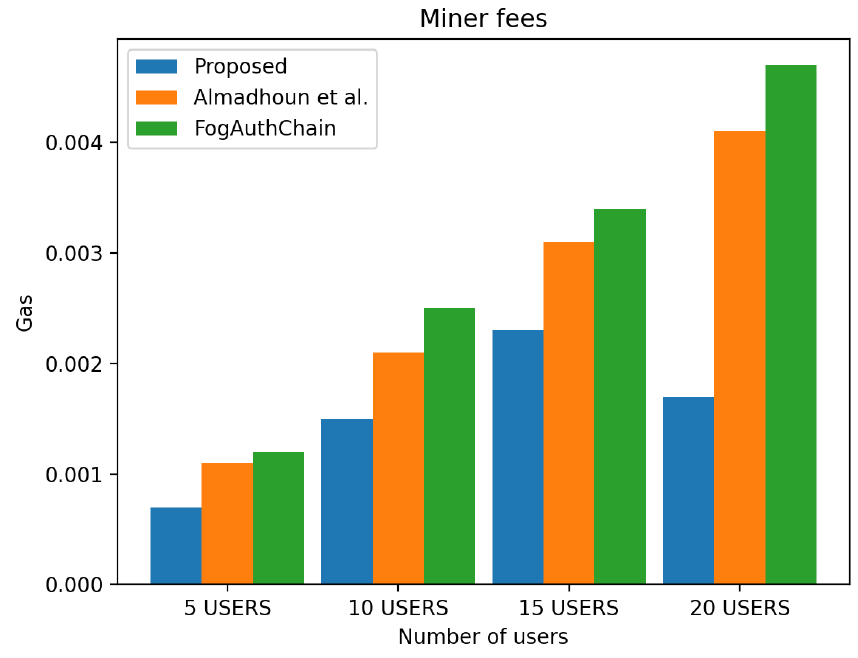
Figure 12. Comparison of experimental results of the proposed system and existing systems (Almad- houn et al. [36] and FogAuthChain [1]) on authentication miner fees.